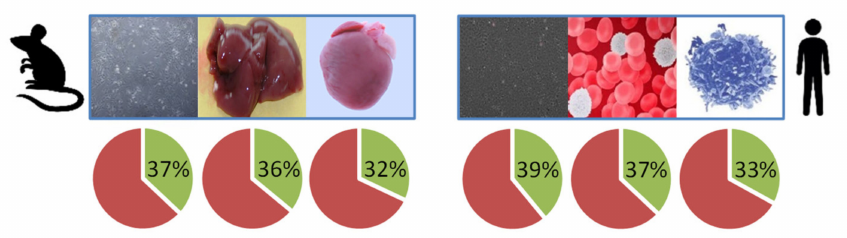
Figure 2. Sequence coverage of lamin A (mouse: UniProtKB accession number P48678, gene Lmna; human: UniProt KB accession number P02545, gene LMNA) in shotgun mass spectrometry (MS) experiments with mouse samples (skin fibroblasts and liver and heart tissue, left) and human samples (U2OS cells, white blood cells and lymphocytes, right). See Figure S1 for more detailed